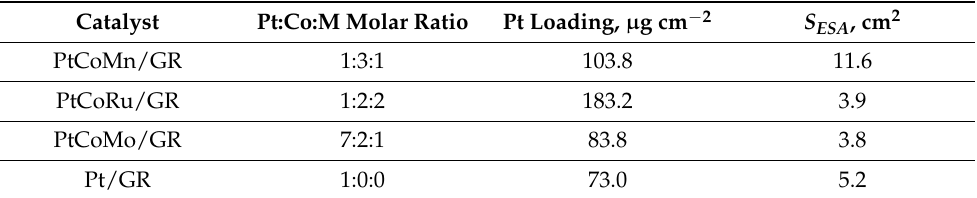
Table 1. The composition of catalysts by ICP-OES, loading, and ESA values of Pt in the synthesized PtCoM/GR and Pt/GR.